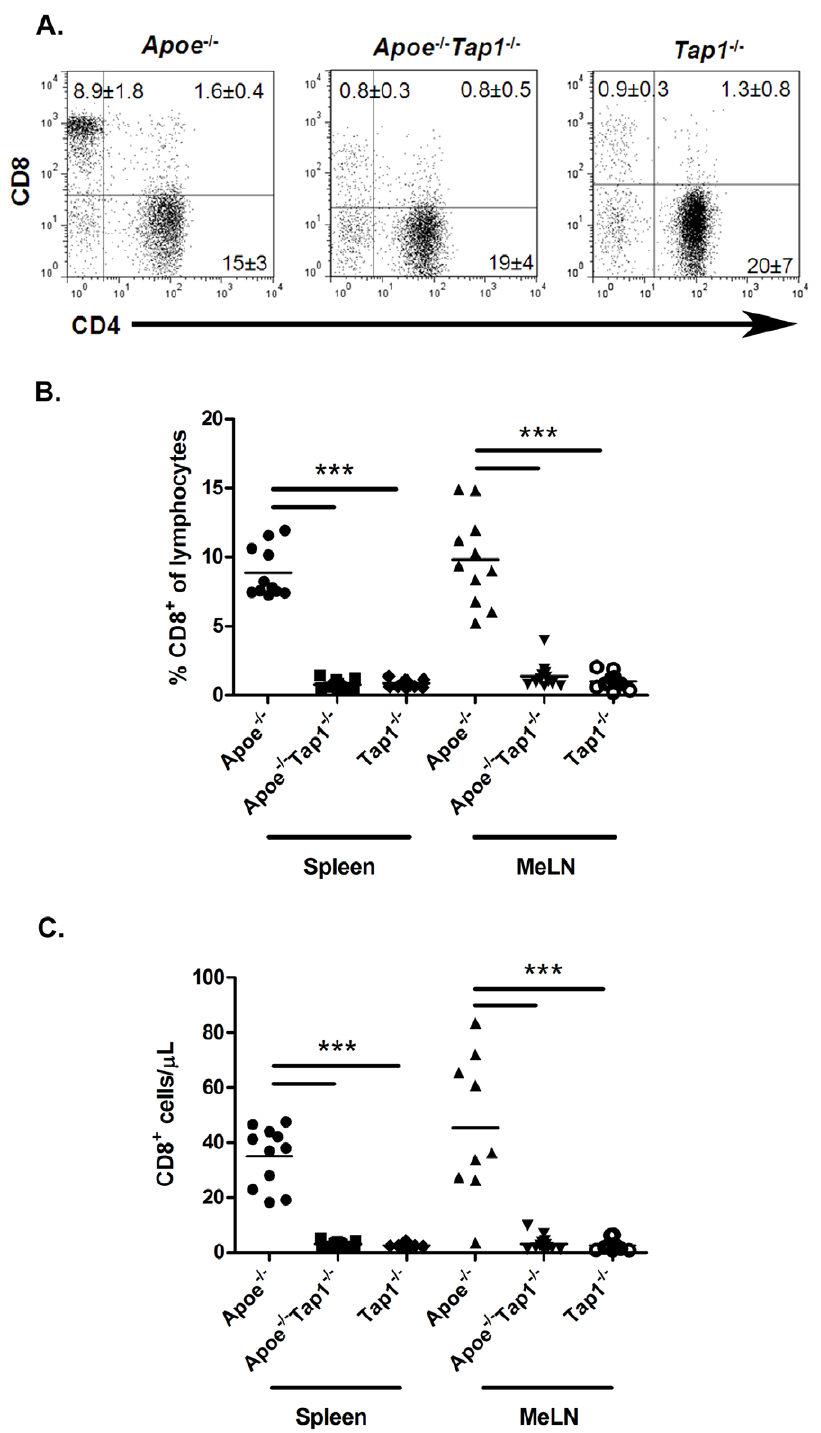
Figure 1. CD8 + T cells in spleen and mediastinal lymph nodes (MeLN). Flow cytometry graphs showing the cell populations in spleen from one representative mouse from each group (A). Numbers given in the graphs are per cent cells out of all lymphocytes. The fraction (B) and total cell count (C) of CD8 + T cells in spleen and MeLN of Apoe 2 / 2 , Apoe 2 / 2 Tap1 2 / 2 and Tap1 2 / 2 mice. The cells were isolated from respective tissue, stained with fluorescent antibodies and analyzed by flow cytometry. As expected, the CD8 + T cell fraction was depressed in the mice lacking the Tap1 gene. Each dot in the figure represents one mouse. *** P , 0.001.